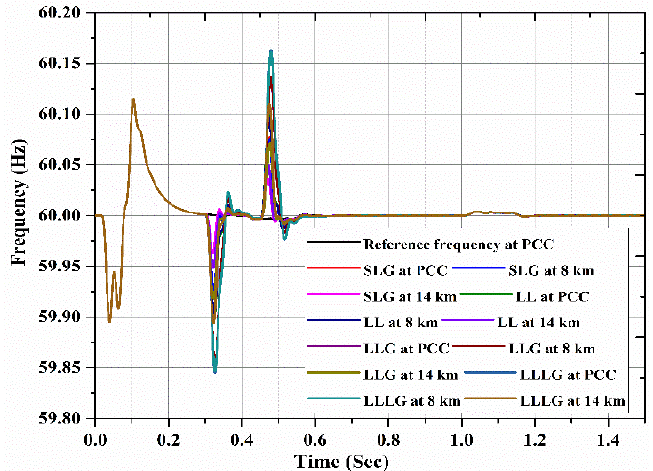
Figure 18. The effective value of PCC voltage for different grid faults.